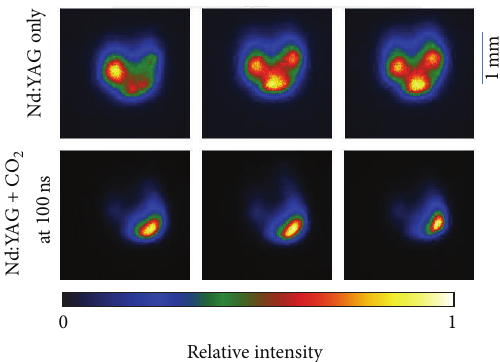
Figure 15: As Figure 14, but with 210 ns imaging delay.